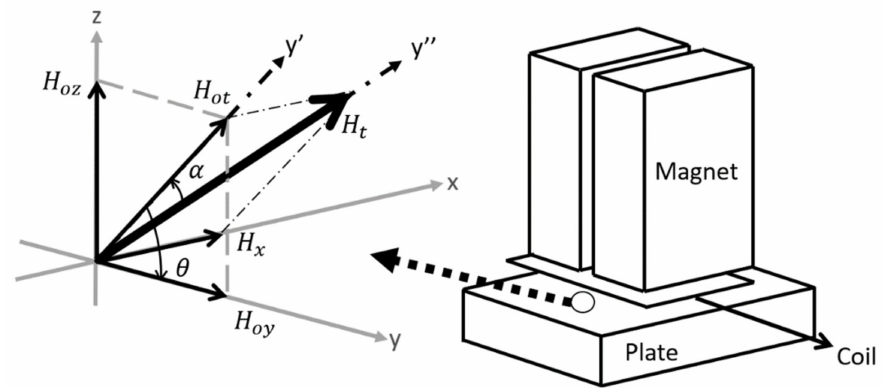
Figure 5. 3D Diagram of the coordinate systems with a section of the PPM